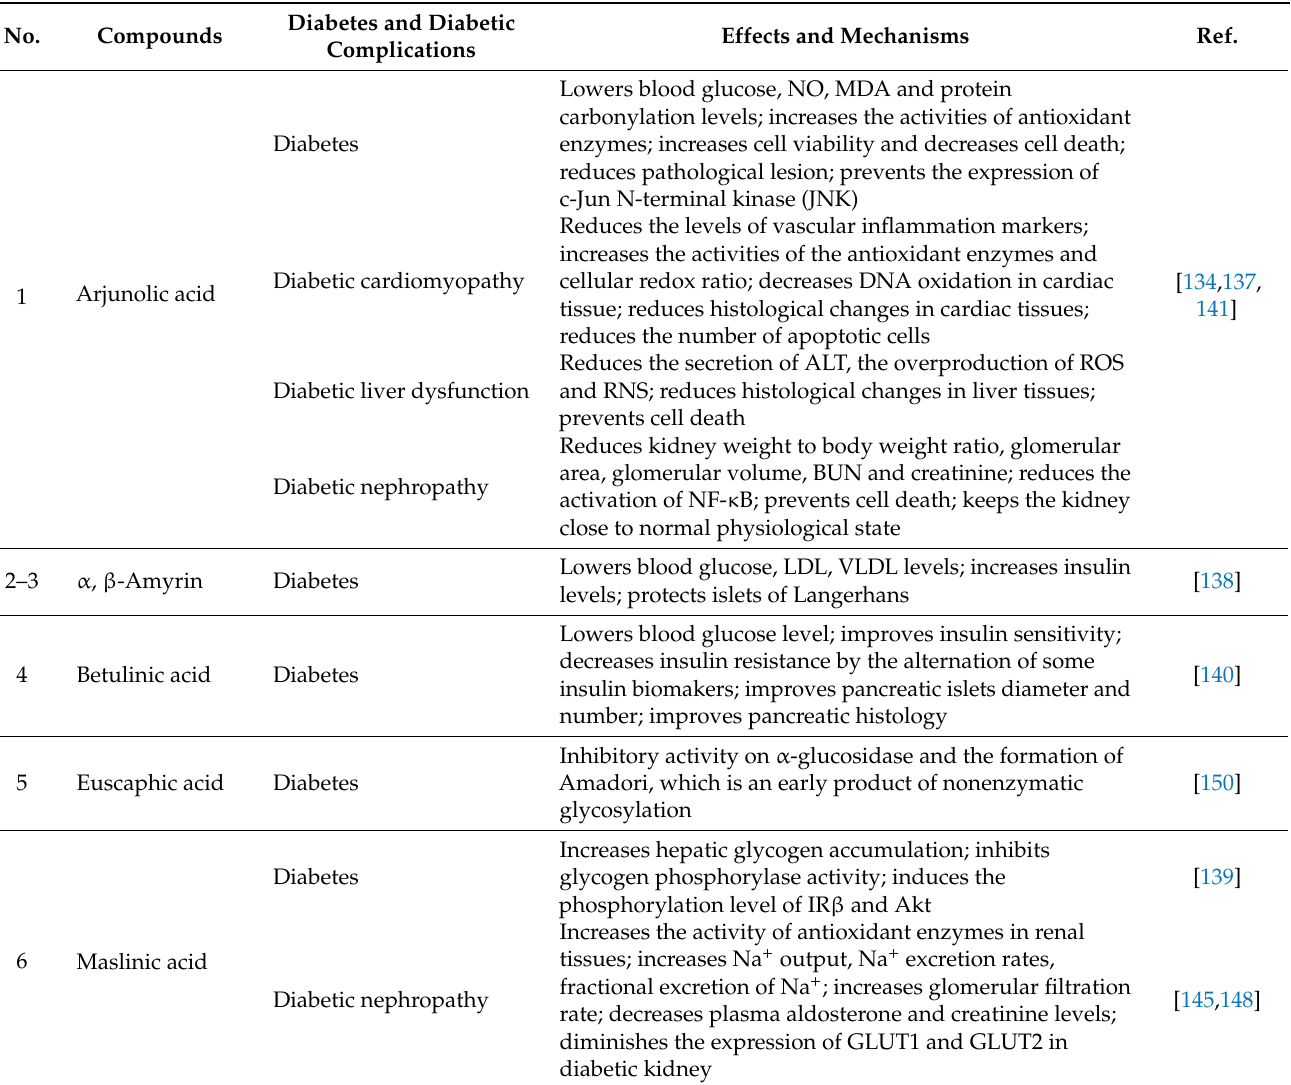
Table 4. The effects and mechanisms of some triterpenoids in O. stamineus in the treatment of diabetes and diabetic complications. Effects and Mechanisms